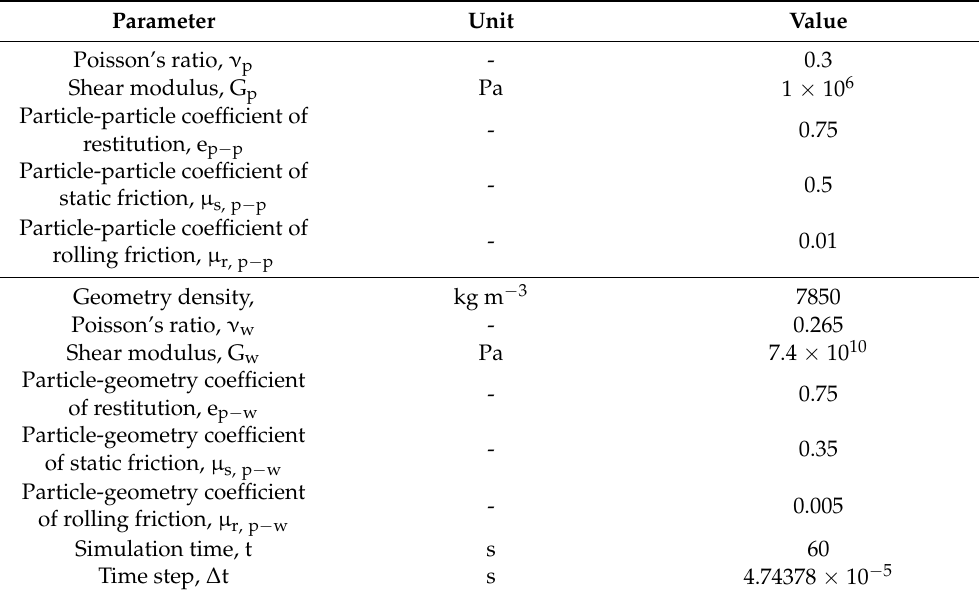
Table 2. Discrete element method (DEM) input parameters. The Poisson’s ratio, ν w , and the shear modulus, G w , are adopted from